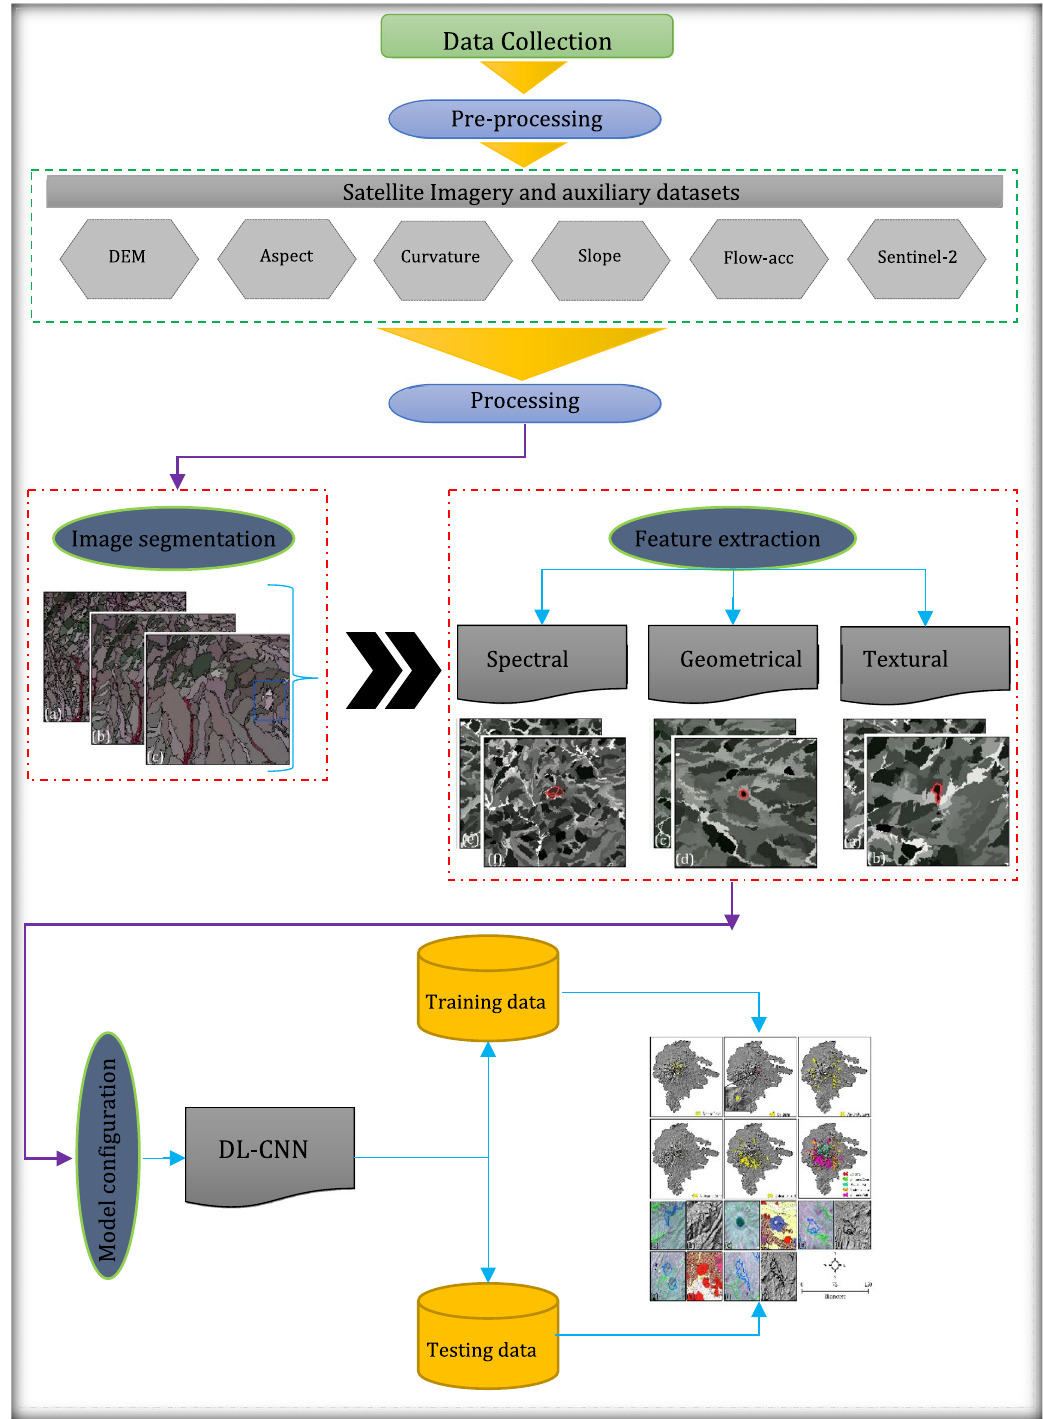
Figure 2. An overview of the methodology used for detecting and mapping volcanic and glacial